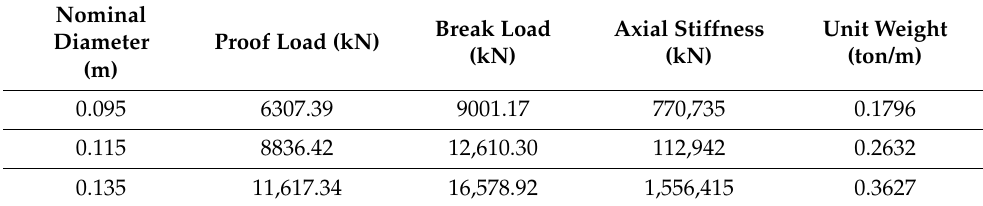
Table 7. Characteristics of selected mooring line.